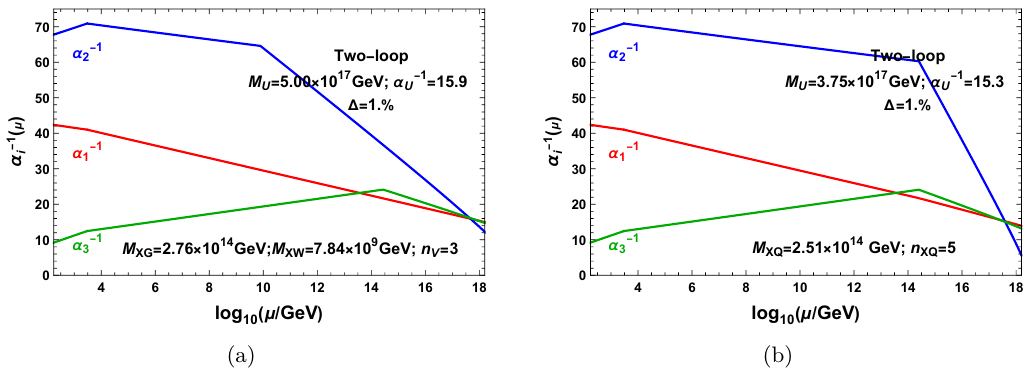
Figure 2 . Two-loop evolution of gauge couplings for the Model 2 with vector-like particles. In the model, k = 85 × 5 and k = 4 . The string-scale gauge coupling relations can be achieved by Y 2 61 3 9 adding 3( XW + XG ) (a) and 5( XQ + XQ )